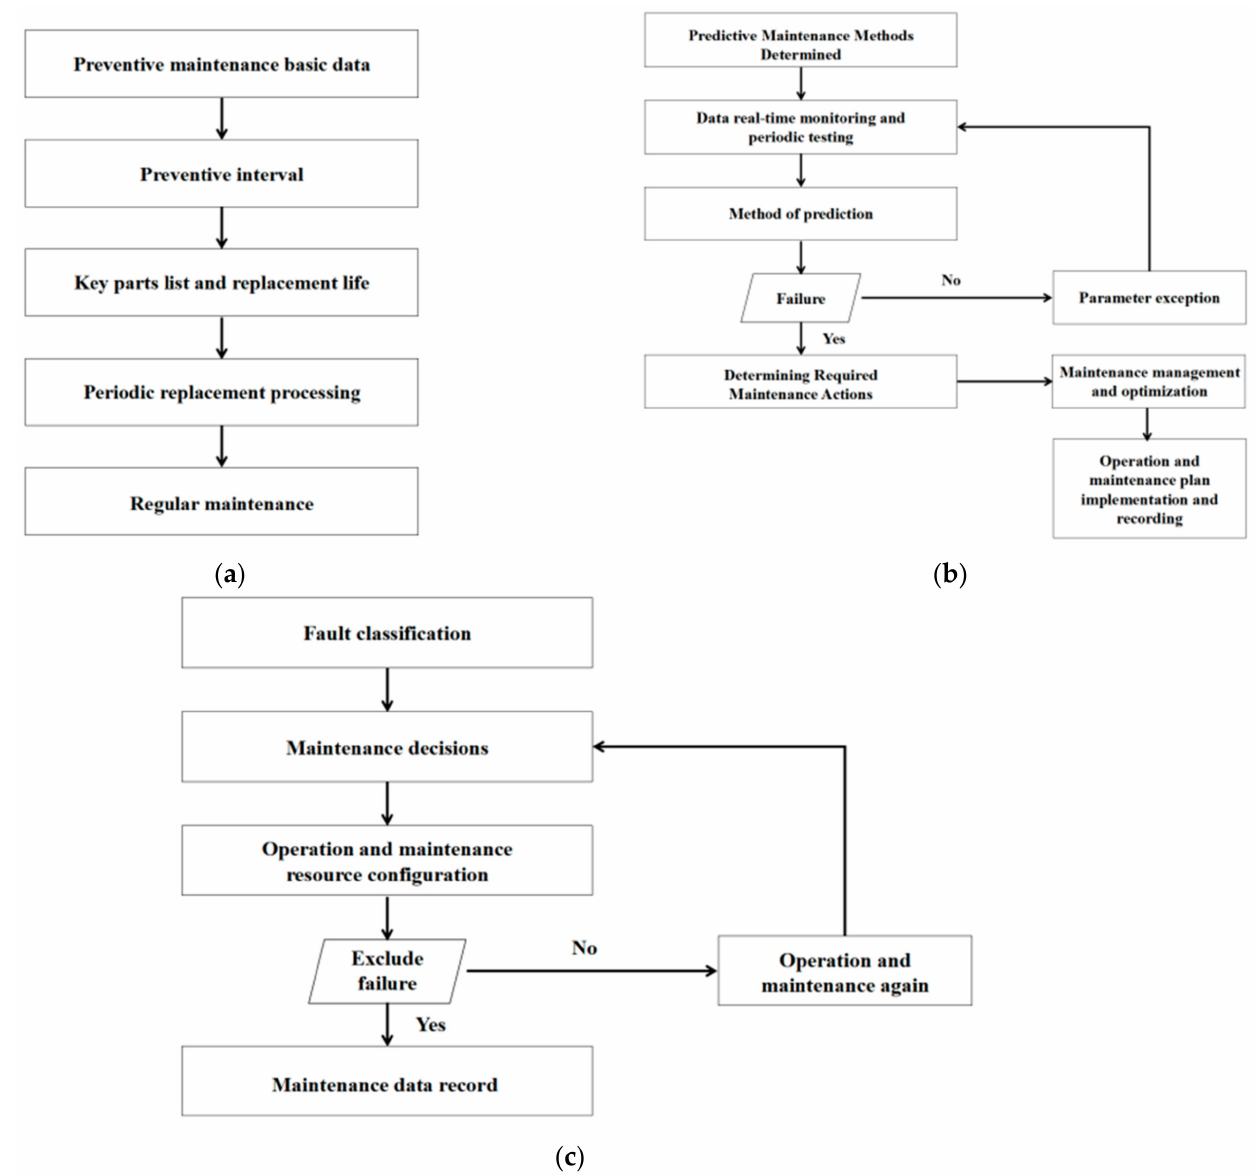
Figure 7. Combine harvester maintenance process: ( a ) preventive maintenance; ( b ) predictive maintenance; ( c ) fault